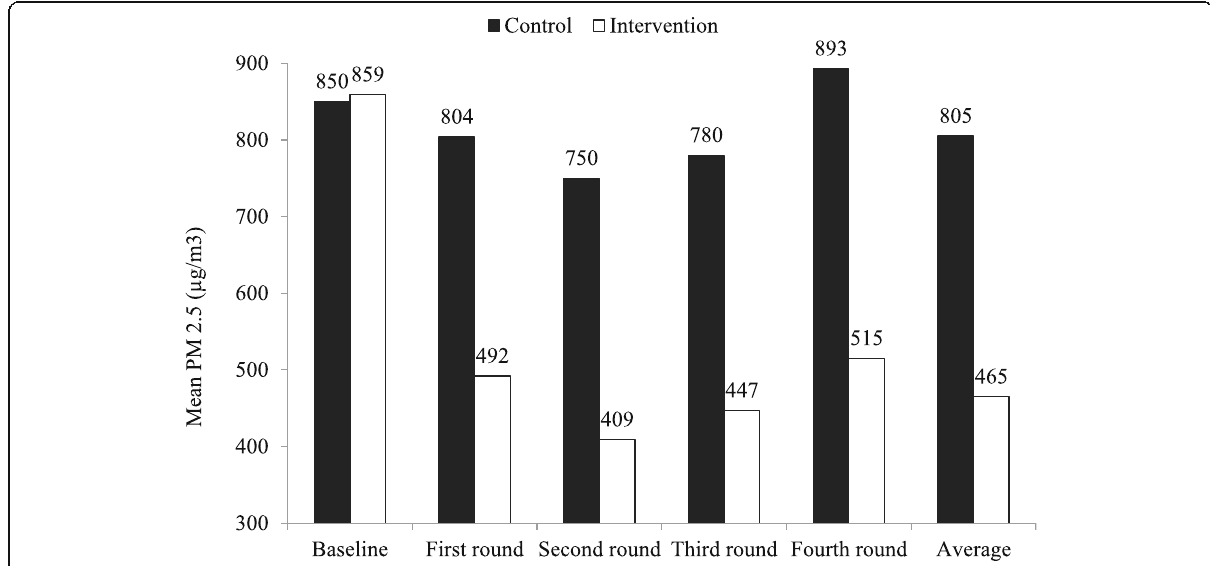
Fig. 3 Mean indoor PM 2.5 concentration in μ g/m 3 by round and arm